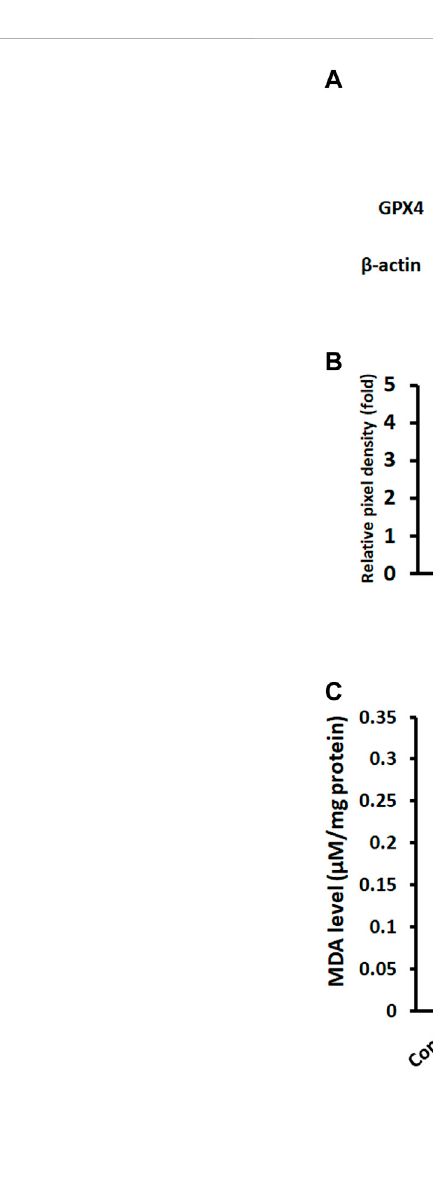
FIGURE 5 Anti-ferroptotic effects of OH Py 2 N 2 in LECs. (A) OH Py 2 N 2 upregulates GPX4 expression. LECs were treated with (1 – 100 µM) OH Py 2 N 2 for 24 h. Control cells were treated identically but without additional of OH Py 2 N 2 . (B) The relative pixel density of GPX4 over loading control. Data presented are a typical representation of triplicate experiments. (** p < 0.01; *** p < 0.001). (C) OH Py 2 N 2 inhibits H 2 O 2 -induced MDA formation. Cells were incubated with or without OH Py 2 N 2 (1, 10 and 100 µM) for 24 h and then treated with 200 µm of H 2 O 2 for 6 h. MDA level in each group was measured. (* p < 0.05; ** p < 0.01; *** p < 0.001) ( n =